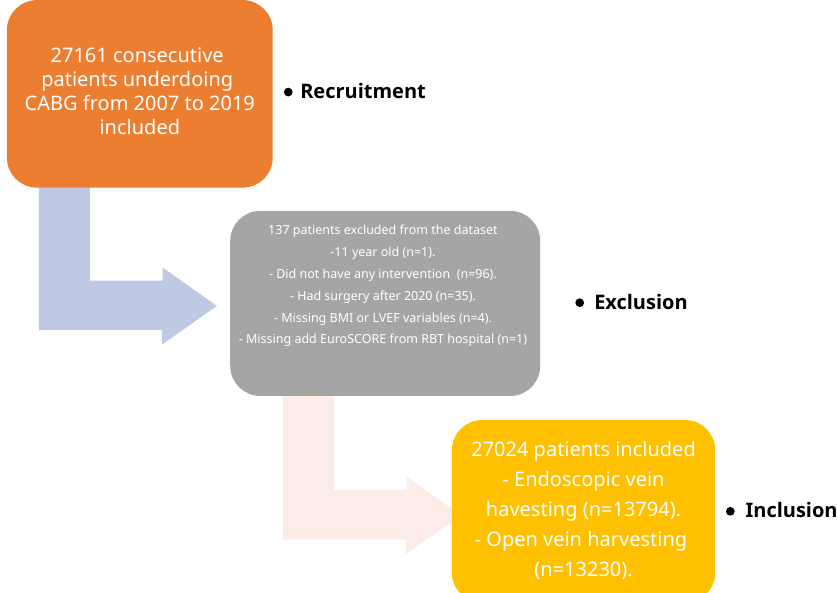
Figure 1. Patient recruitment and flow chart.